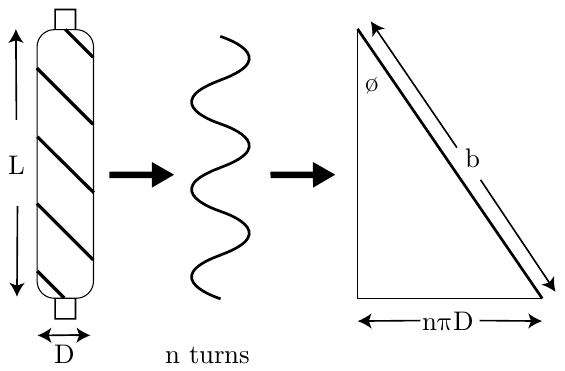
Figure 2. Geometry of McKibben type pneumatic artificial muscle (PAM). the left figure shows the PAM. The middle figure shows a thread of the PAM. The right figure shows the length and angle how the thread wounds the